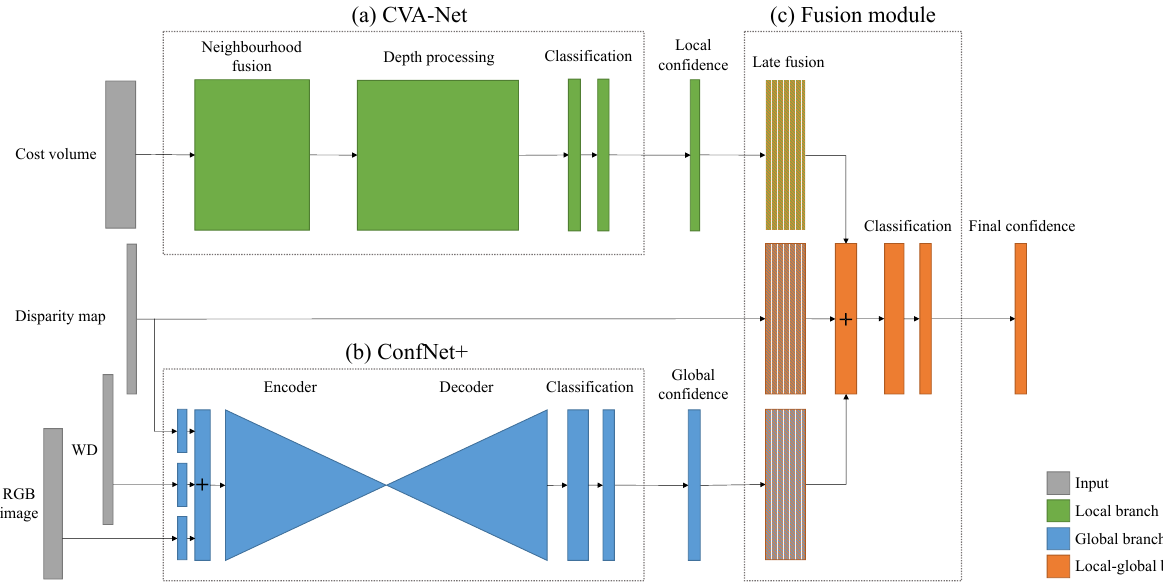
Figure 1. Overview of LGC+ in tetra-modal configuration. The network consists of a local and a global branch, which are combined in a late fusion module. A cost volume is processed by the local branch CVA-Net (a), while the left RGB image and the corresponding disparity map, as well as the warped difference (WD), serve as the input for the global branch ConfNet+ (b). This global branch utilises an encoder-decoder architecture with a large receptive field. Both branches output a confidence prediction, which, together with the disparity map, are used to estimate a final confidence map in the fusion module